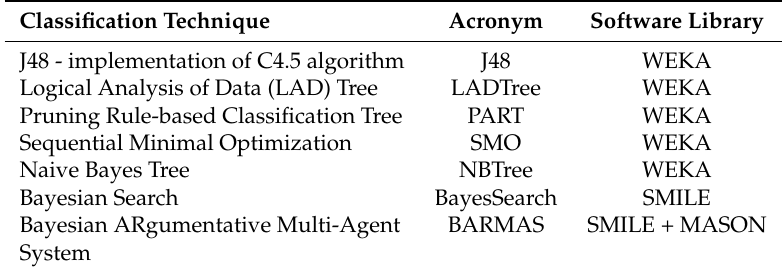
Table 1. Summary of the considered classification